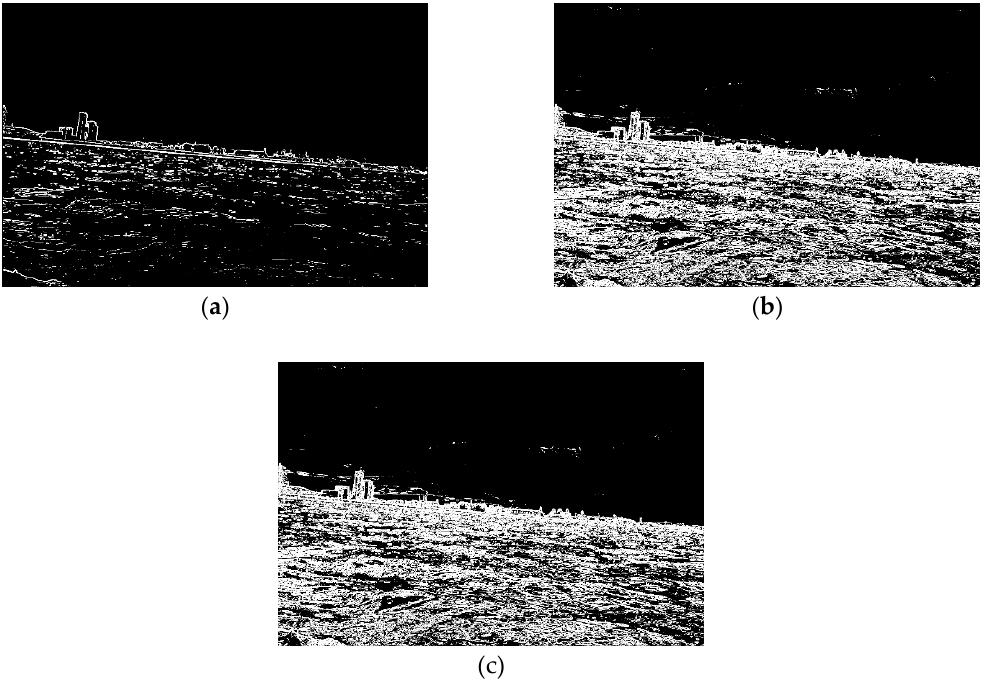
Figure 2. Results of edge detection ( a ) Adaptive filter; ( b ) Sobel operator; ( c ) Prewitt operator.